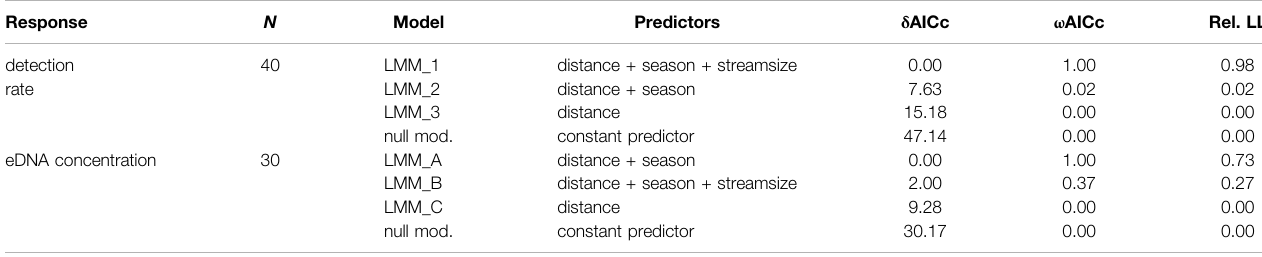
TABLE 4 | Ranking of the three best performing candidate models to explain the detection rate (proportion of positive PCRs) and eDNA concentration in relation to the respective null model (with a constant predictor as fi xed effect). Response